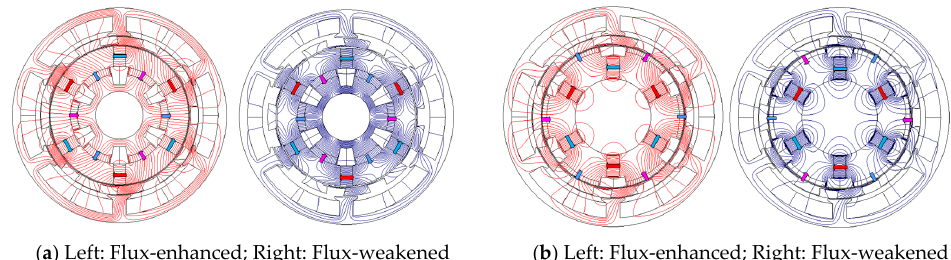
Figure 3. Configurations and flux regulation principle of PS-SF-HMMMs with parallel and series magnetic circuits. ( a ) Parallel; ( b ) Series.